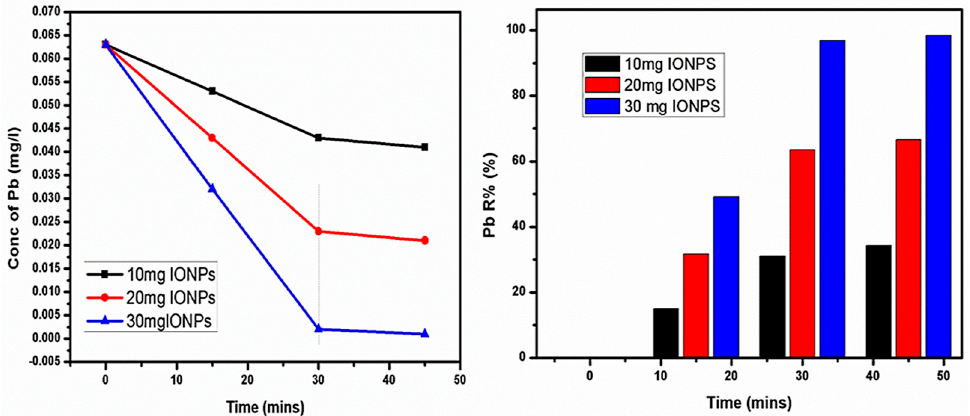
Figure 10. Removal of Zn using IONPs at different concentrations and their removal%.